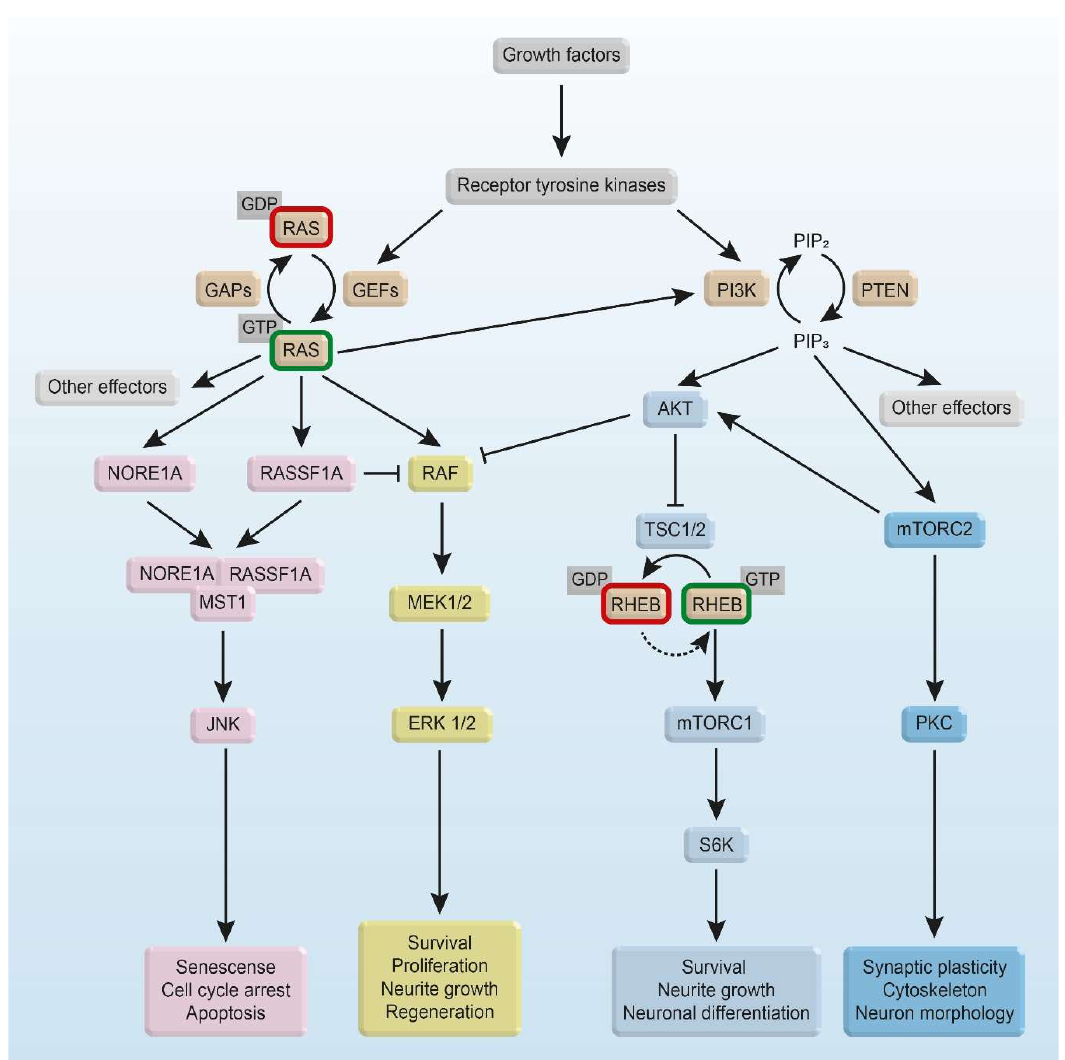
Figure 3. Schematic overview of RAS and PI3K pathway and their interconnection. Binding of growth factors to receptor tyrosine kinases results in activation of RAS and PI3K signaling pathway. Complex-formation of NORE1, RASSF1A, and MST1, together with activated RAS leads to JNK-mediated senescence, cell-cycle arrest or apoptosis [16,84]. RAS-mediated activation of RAF/MEK/ERK signaling plays a role in survival, proliferation, neurite growth, and neuronal regeneration, but the effect differs between various types of neurons [85]. PI3K-mediated phosphorylation of AKT promotes TSC dissociation from lysosomes and RHEB activation. The activation of RHEB by GEF is still under discussion (dashed arrow). Downstream of RHEB, mTORC1 and S6K suppress autophagy and promote survival, neurite growth, and neuronal differentiation [86]. Furthermore, PI3K-mediated mTORC2 activation plays a role in PKC-dependent synaptic plasticity, actin cytoskeleton dynamics, and neuron morphology [87,88]. Strong activation of AKT directly inhibits RAF (illustrated by T-bar) and thereby leading to downregulation of ERK1/2 signaling [89].